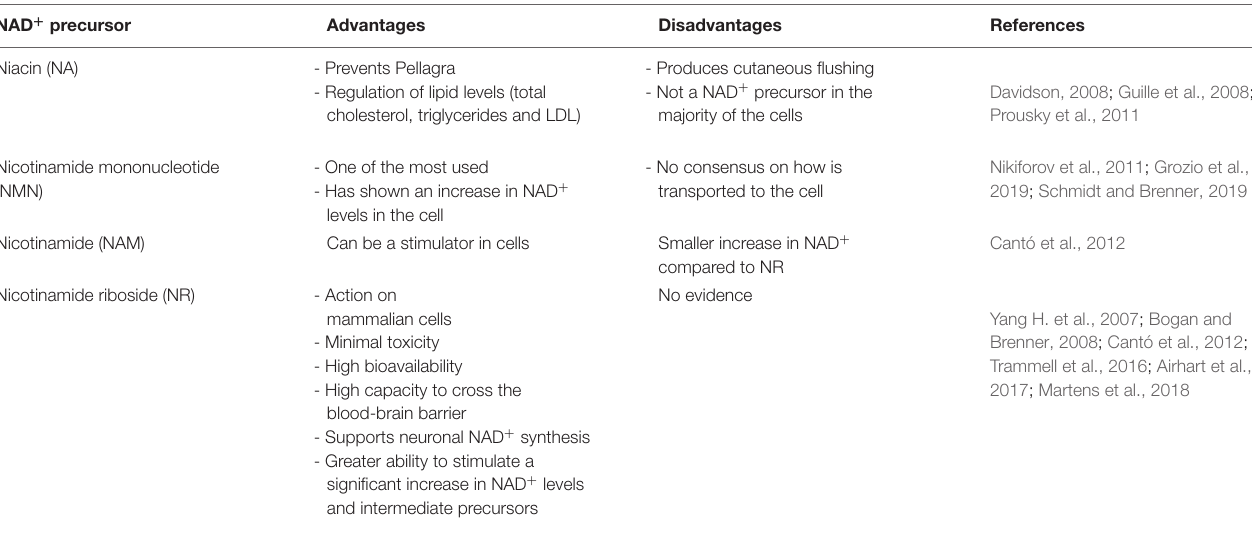
TABLE 2 | Comparison between the different NAD +